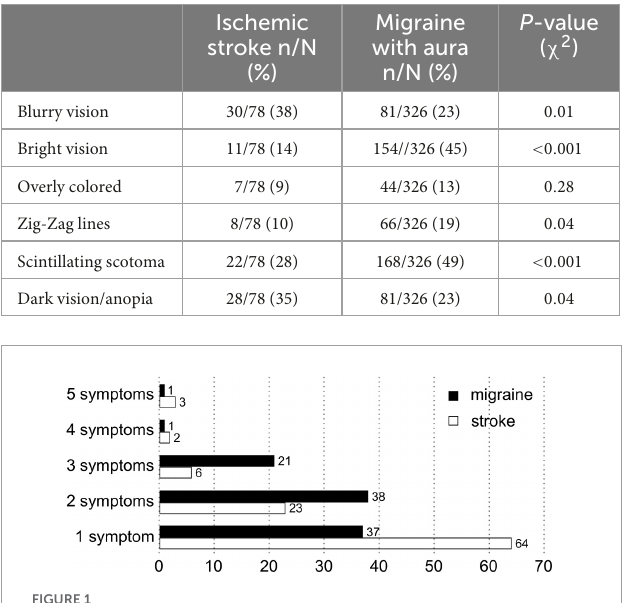
FIGURE1 Distribution of number of visual symptoms (in